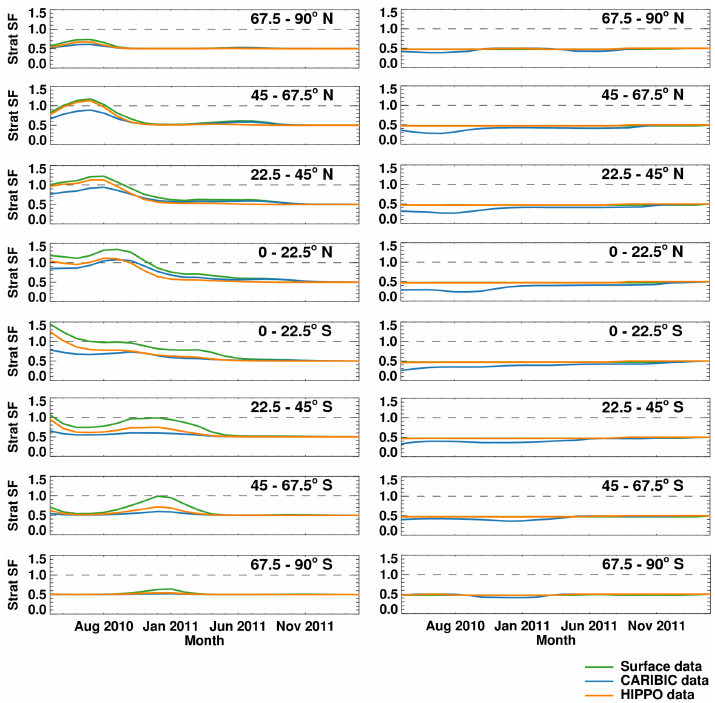
Figure 6. Pseudo observation tests optimizing N 2 O stratospheric loss frequencies. Shown are a posteriori scaling factors (SF) for strato- spheric loss frequencies in each of eight equal latitude bands for pseudo observation tests in which we optimize solely the stratospheric loss frequencies (left panels) or the emissions and stratospheric loss frequencies jointly (right panels). The latitude range of each band is indicated in the upper right hand corner of each panel. The true model value (1.0) is indicated by the black dashed line; each test started with a priori SF of 0.5 for each latitude band. Results obtained using surface data, CARIBIC data, and HIPPO data are shown in green, blue, and orange,